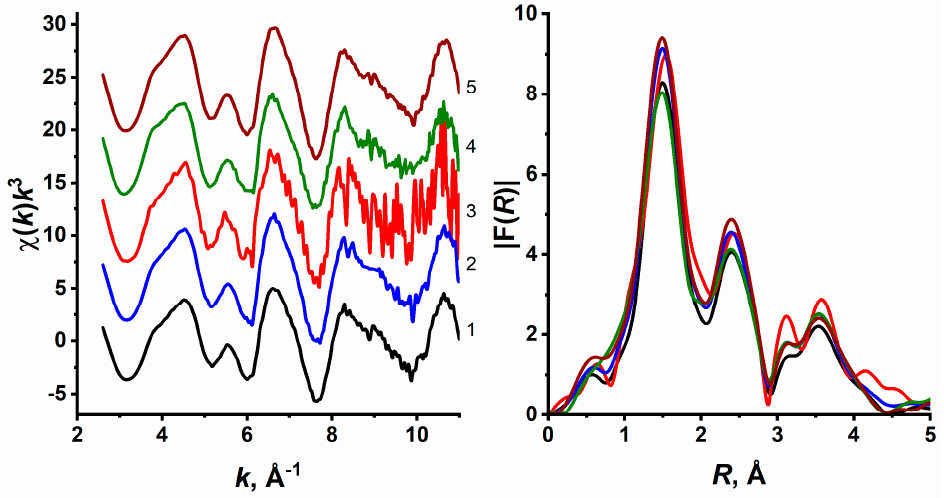
Figure 1. Fe K– edge EXAFS spectra ( left ) and their Fourier transform modules without consideration of the phase shift ( right ) of complexes 1 – 5 .